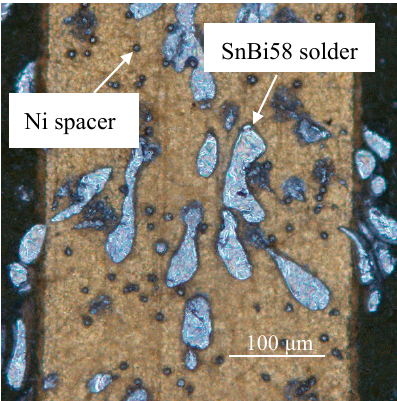
Figure 7. The laminated ACFs on the PCB electroless nickel immersion gold (ENIG) metal electrodes.